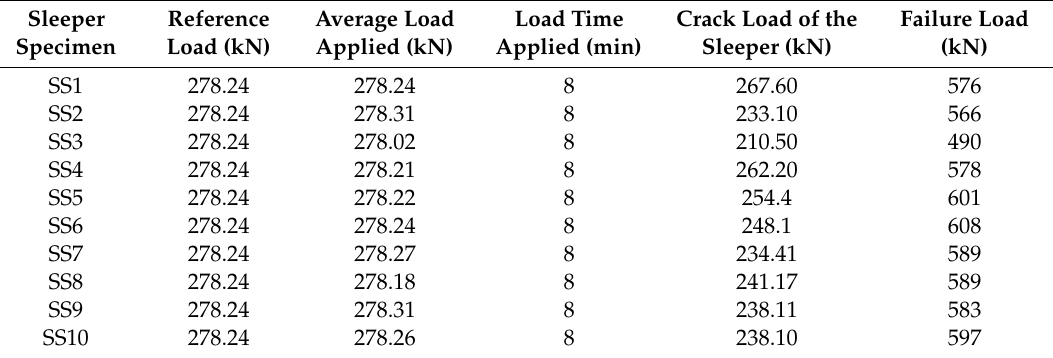
Figure 5. Average failure load of the sleepers tested with load on the support. Table 2. Summary of positive moment at the support. Table 2. Summary of positive moment at the support.